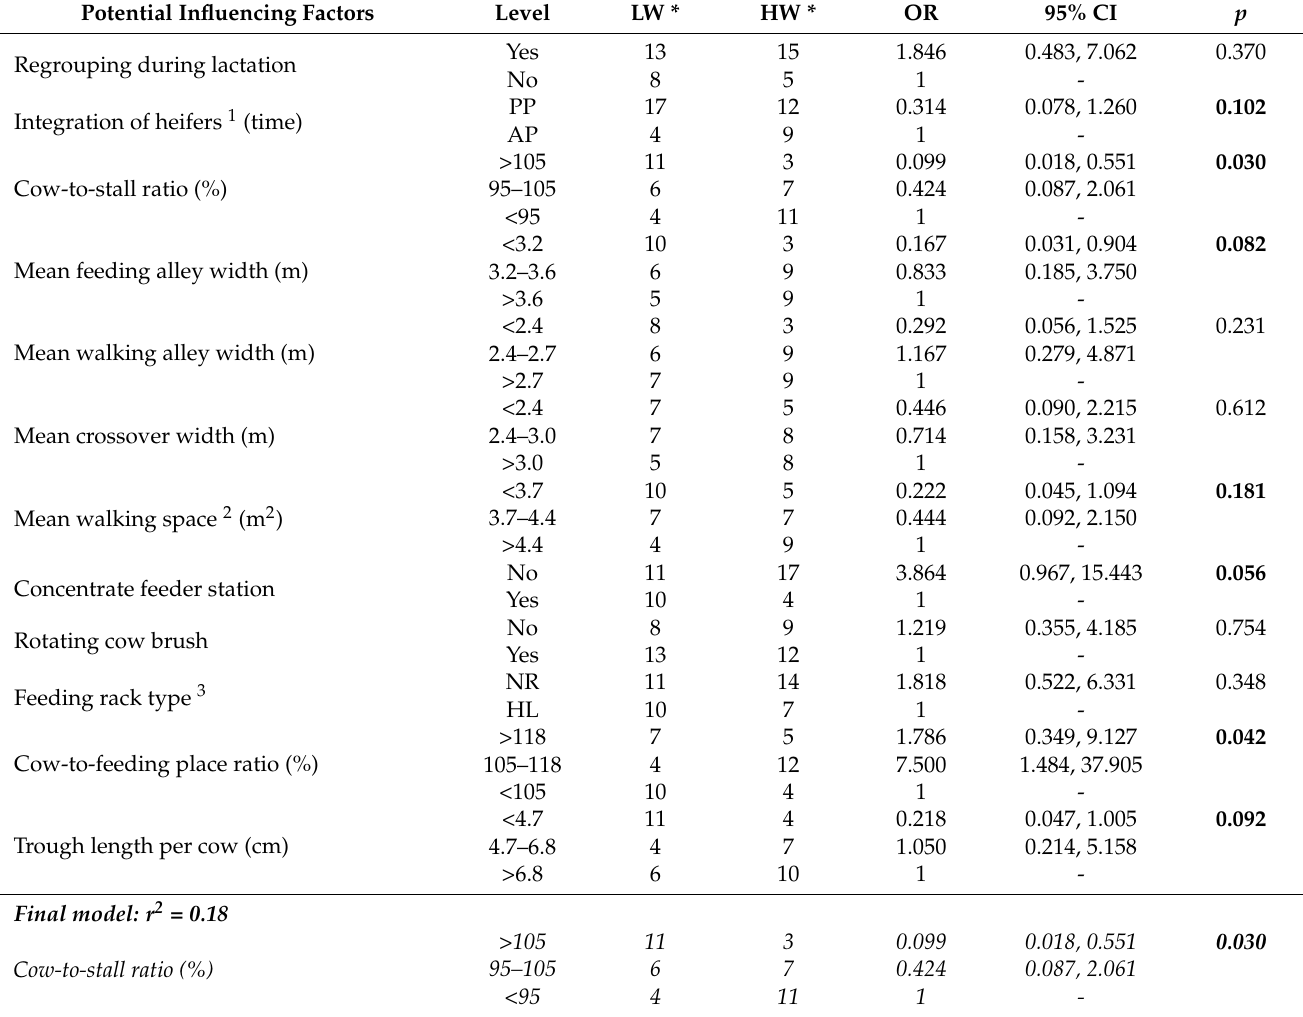
Table 8. Potential influencing factors in univariable logistic regression analysis associated with being a herd with high welfare level (HW) within the criterion “social behaviour” [Odds ratio, confidence interval, bold p -values ( p < 0.20) were included in multivariable analyses; final model presented at the bottom of the